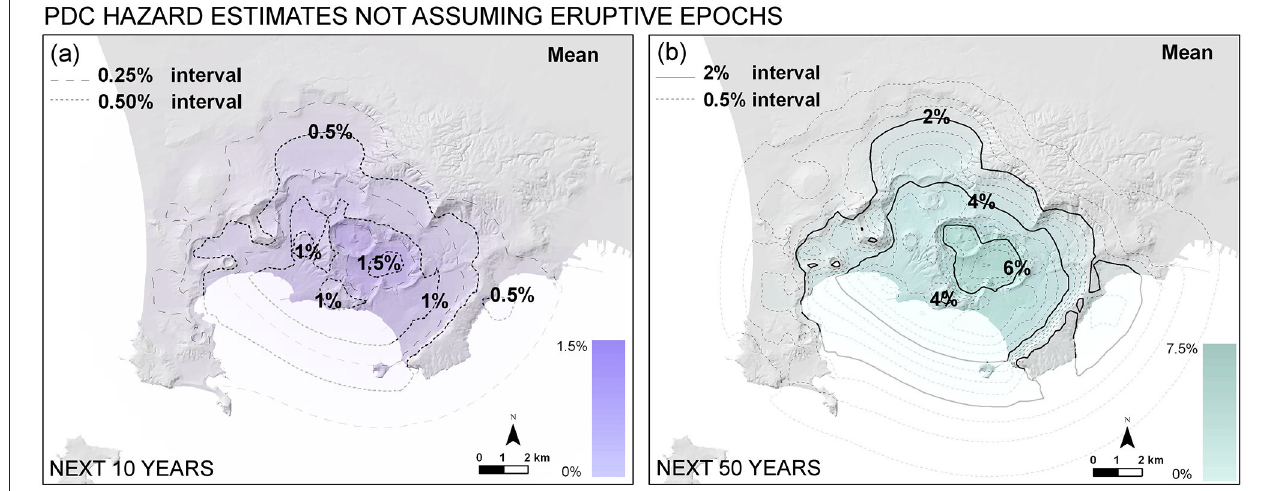
FIGURE 9 | Temporal PDC invasion hazard map based on the vent opening map and the areal size distributions displayed in Figure 3 , and temporal estimates without assuming that the volcano entered a new eruptive epoch. In (a,b) contours and colors indicate the mean percentage probability of PDC invasion in the next 10 and 50 years, respectively. In (b) we included the possibility of a sequence of multiple events in the period